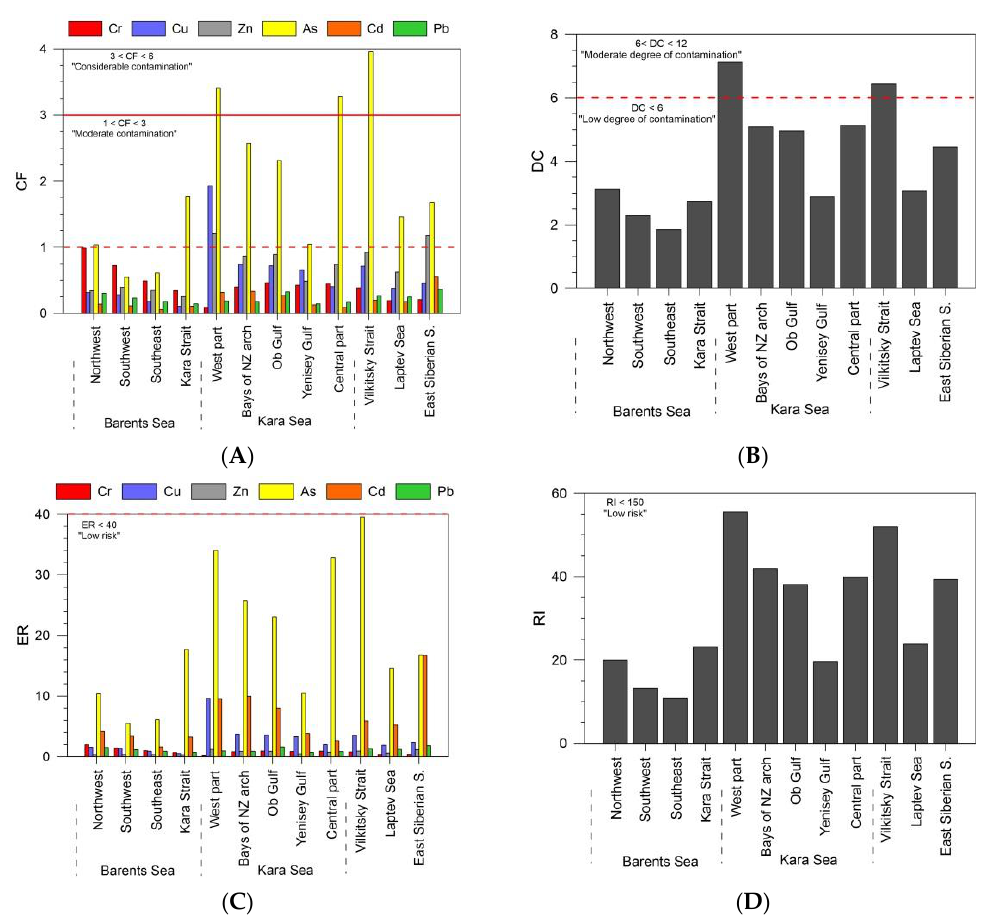
Figure 6. The criteria of contamination level and potential ecological risk of toxic elements in surface bottom sediments from the Arctic Seas: ( A ) Contamination factor CF; ( B ) Degree of contamination DC; ( C ) Potential ecological risk factor ER; ( D ) Risk index RI. While calculating these criteria, a mean content of 6 toxic elements was used from several (up to 5) nearby sites. In our case, 20 sampling sites were combined into 12 locations.